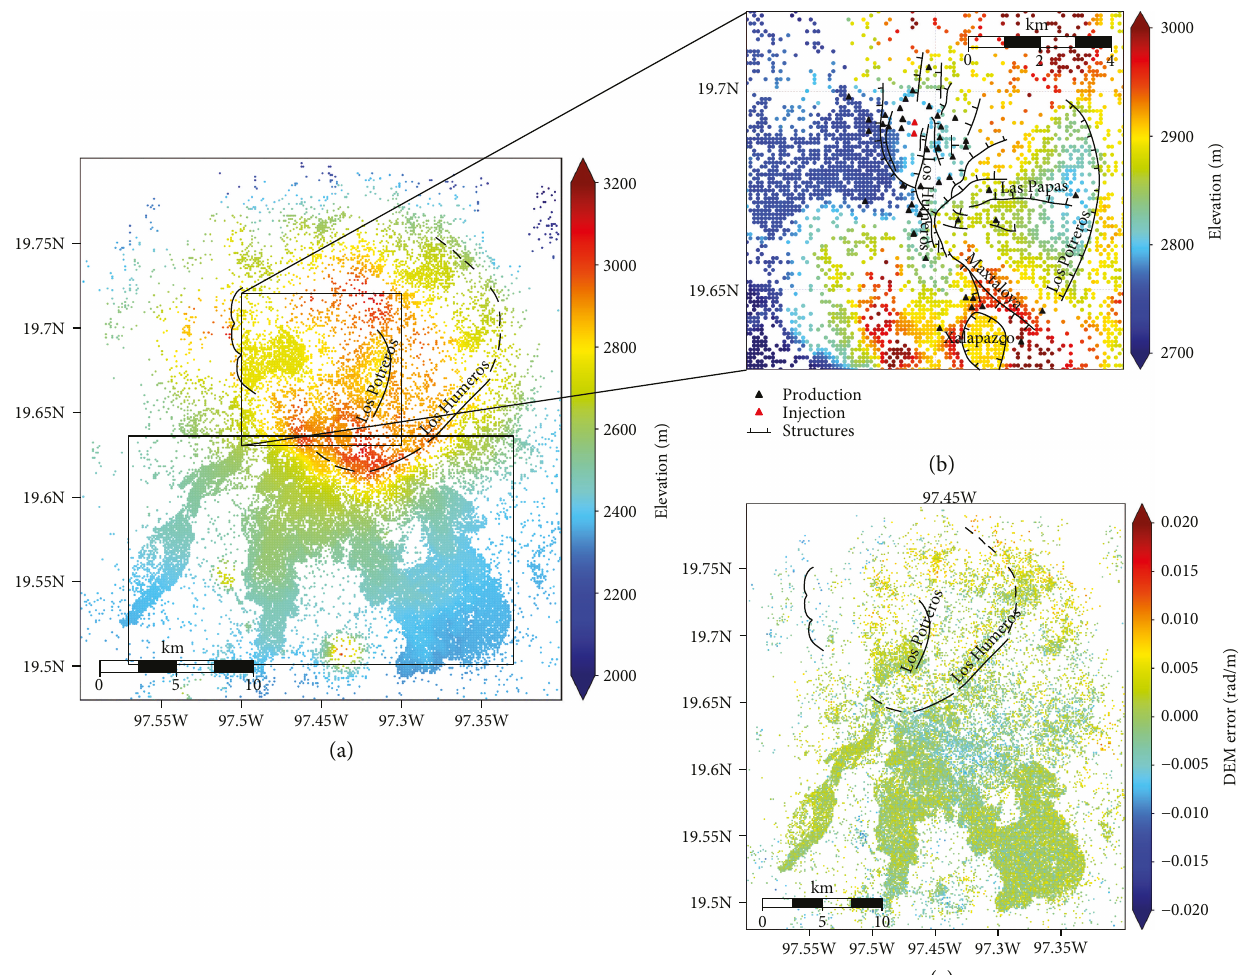
Figure 3: Elevation of the PS points of the entire study area (a) and at the LHGF (b) and the error associated with the DEM (c). The black rectangle in (a) highlights the region used for tropospheric